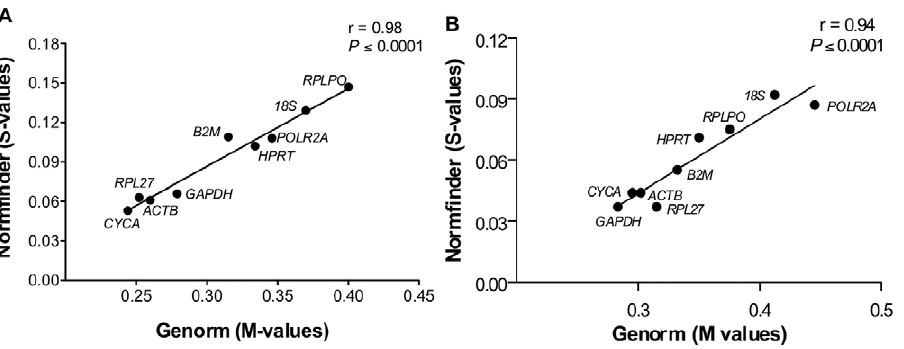
Figure 3. Determination of the stable genes common to both Genorm and Normfinder algorithms. Correlation analysis between M- values (Genorm) and S-values (Normfinder) representing the expression stability of each candidate gene for (A) n=12 and (B) n=33. The r-value signifies the coefficient of correlation. A P # 0.05 was considered to be significant.